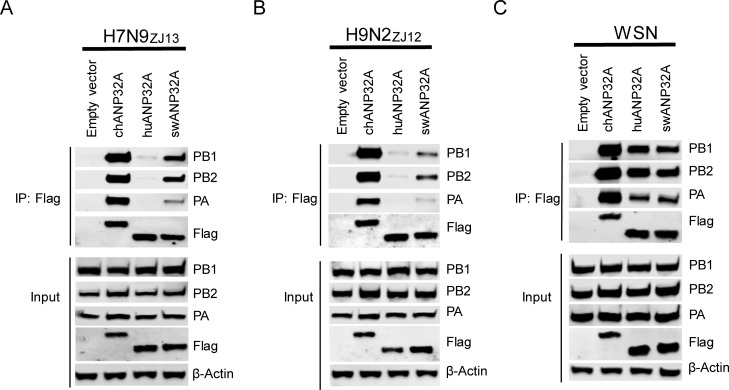
ANP32A proteins from different species interact with different polymerase trimeric complexes.DKO cells were transfected with different ANP32A (0.6μg) and polymerase plasmids (0.6μg PA, 1μg PB1, and 1μg PB2) from avian influenza viruses H7N9ZJ13
(A), H9N2ZJ12
(B), human influenza virus polymerase WSN (C). The cells were lysed at 24 h post-transfection. Co-IP was performed using Anti-FLAG M2 Magnetic Beads, followed by Western blotting to detect the ANP32A and viral proteins by using specific antibodies: PA antibody (NBP2-42874, NOVUS), PB1 antibody (NBP2-42877, NOVUS), PB2 antibody (NBP2-42879, NOVUS), Anti-Flag antibody (F1804, SIGMA).